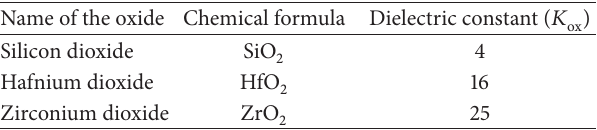
Table 2: List of oxides considered for gate insulation with their dielectric constants.